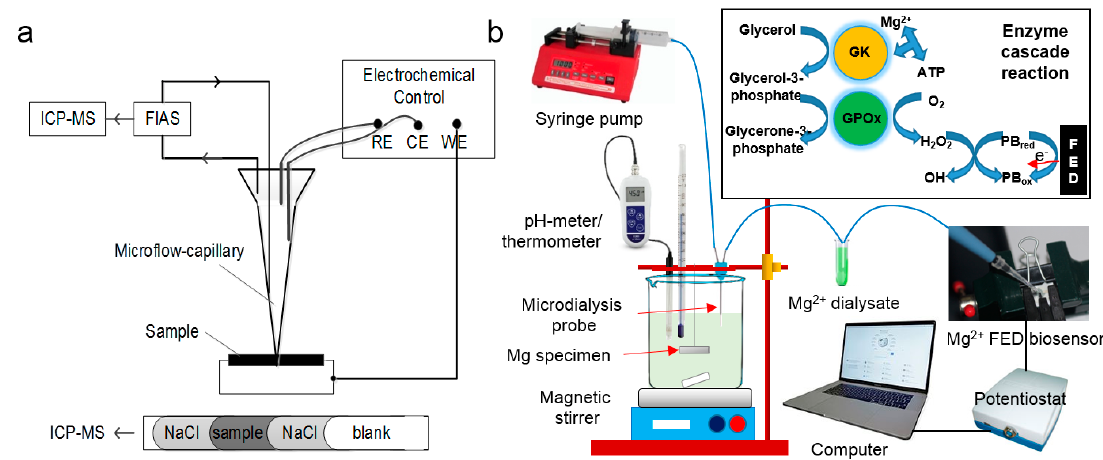
Figure 8. Experimental setup of: ( a ) micro-flow-capillary-coupled Inductively Coupled Plasma Mass Spectrometer (ICP-MS); ( b ) coupled microdialysis probe-fabric-based electrochemical device (FED) biosensor connected to a potentiostat (inset: dialysate is dropped at the reaction region of the biosensor that was immobilized with the GK and GPOx enzymes to detect Mg 2+ ions via enzymes cascade reaction). Adapted with permission from Elsevier and Springer Nature [82,83].